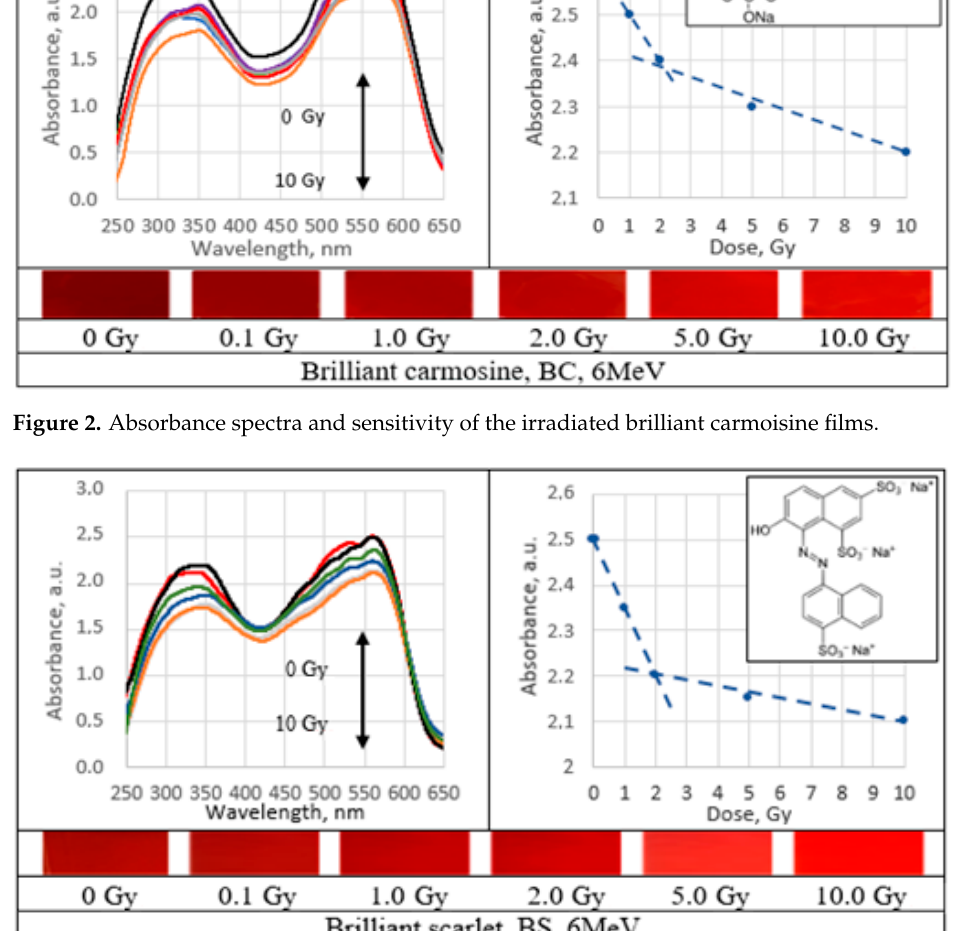
Figure 4. Absorbance spectra and sensitivity of the irradiated methyl red films. Figure 5. Absorbance spectra and sensitivity of the irradiated methylene blue films.